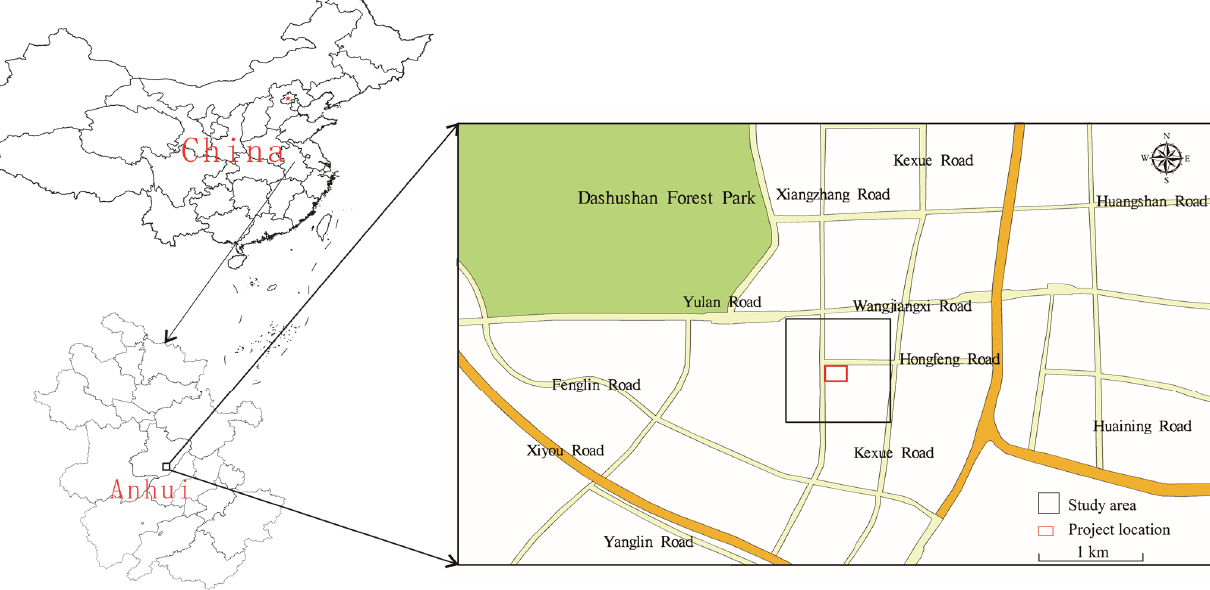
Figure 1. Location map of the project example.